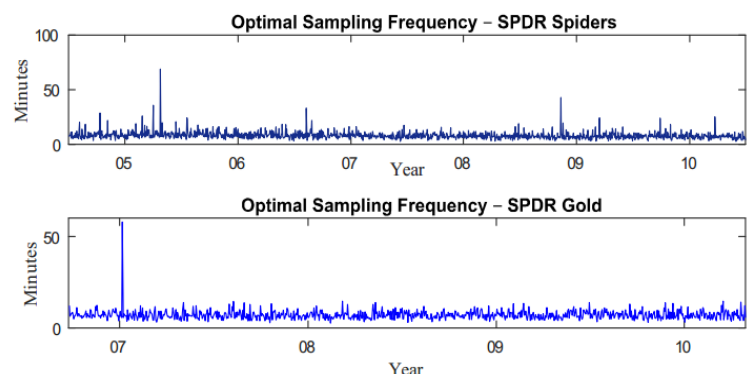
Figure 1. Optimal sampling frequency.